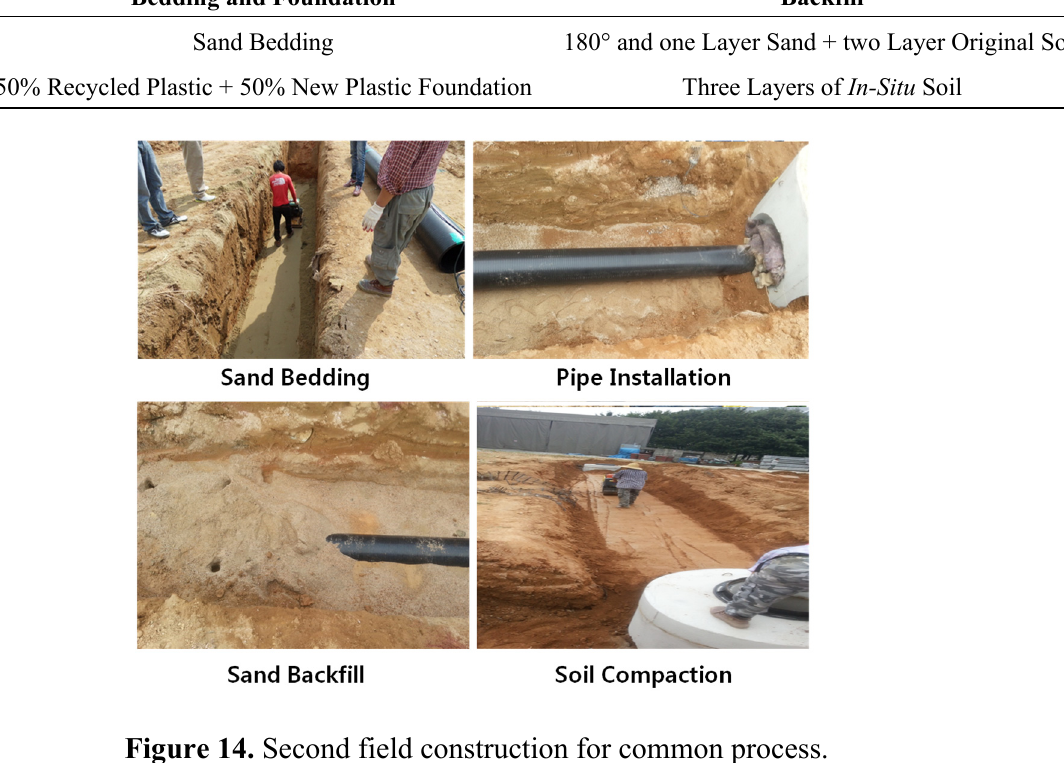
Figure 14. Second field construction for common process.